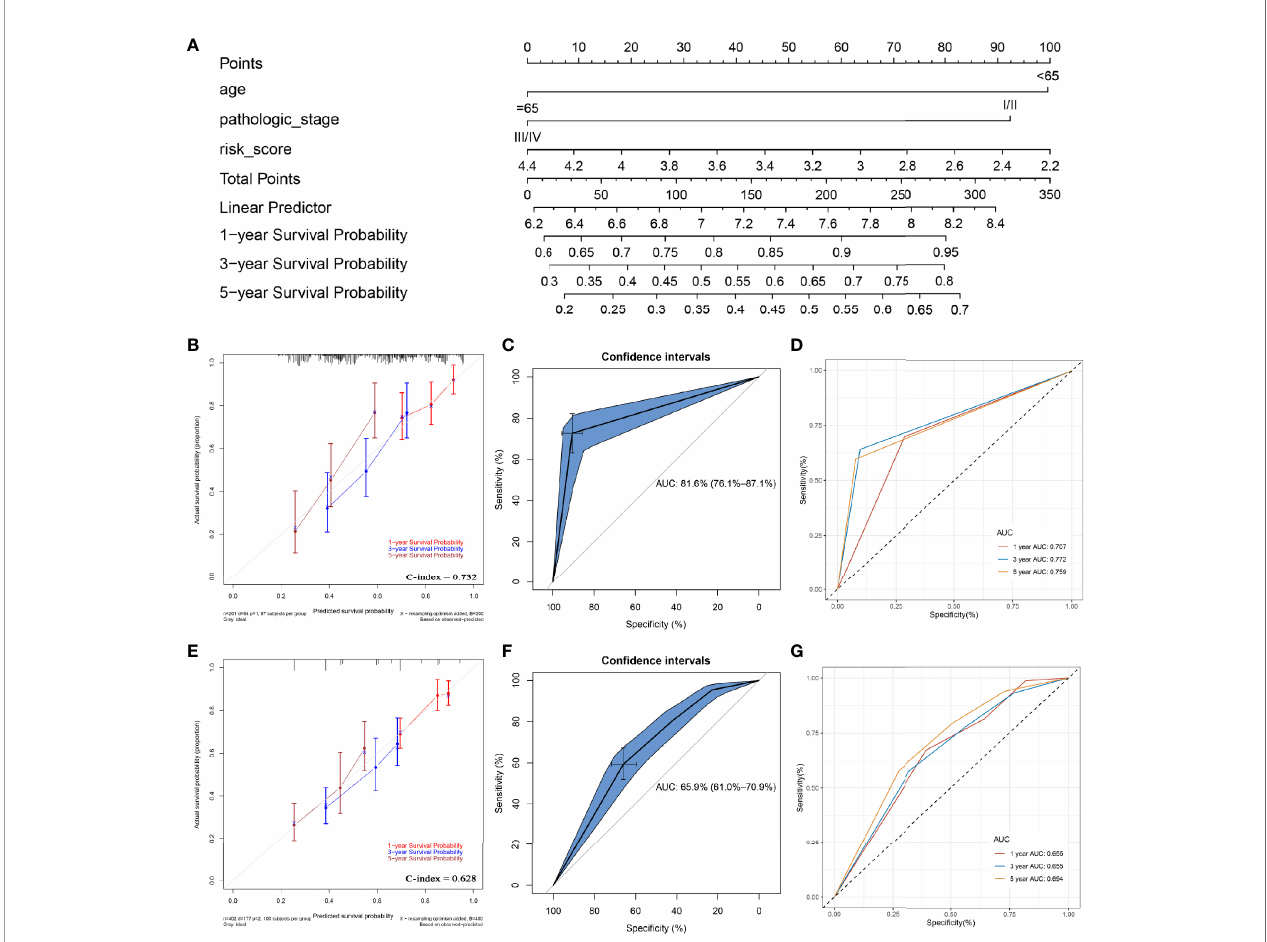
FIGURE 7 | Construction of a nomogram with/without the ARG signature. (A) the nomogram with the ARG signature for predicting the proportion of patients with 1-, 3- or 5-year OS. (B) the calibration plots for predicting 1-, 3- or 5- year OS by using TCGA-BLCA data. (C) receiver operating characteristic (ROC) curves and area under the curve (AUC) statistics to evaluate the diagnostic ef fi ciency of the nomogram with ARG signature in TCGA-BLCA data. (D) Time-dependent ROC curves indicating the predictive accuracy of the nomogram with ARG signature for 1-, 3-, or 5- year OS. (E) the calibration plots for predicting 1-, 3- or 5- year OS by using TCGA-BLCA data. (F) receiver operating characteristic (ROC) curves and area under the curve (AUC) statistics to evaluate the diagnostic ef fi ciency of the nomogram without ARG signature in TCGA-BLCA data. (G) Time-dependent ROC curves indicating the predictive accuracy of the nomogram without ARG signature for 1-, 3-, or 5- year